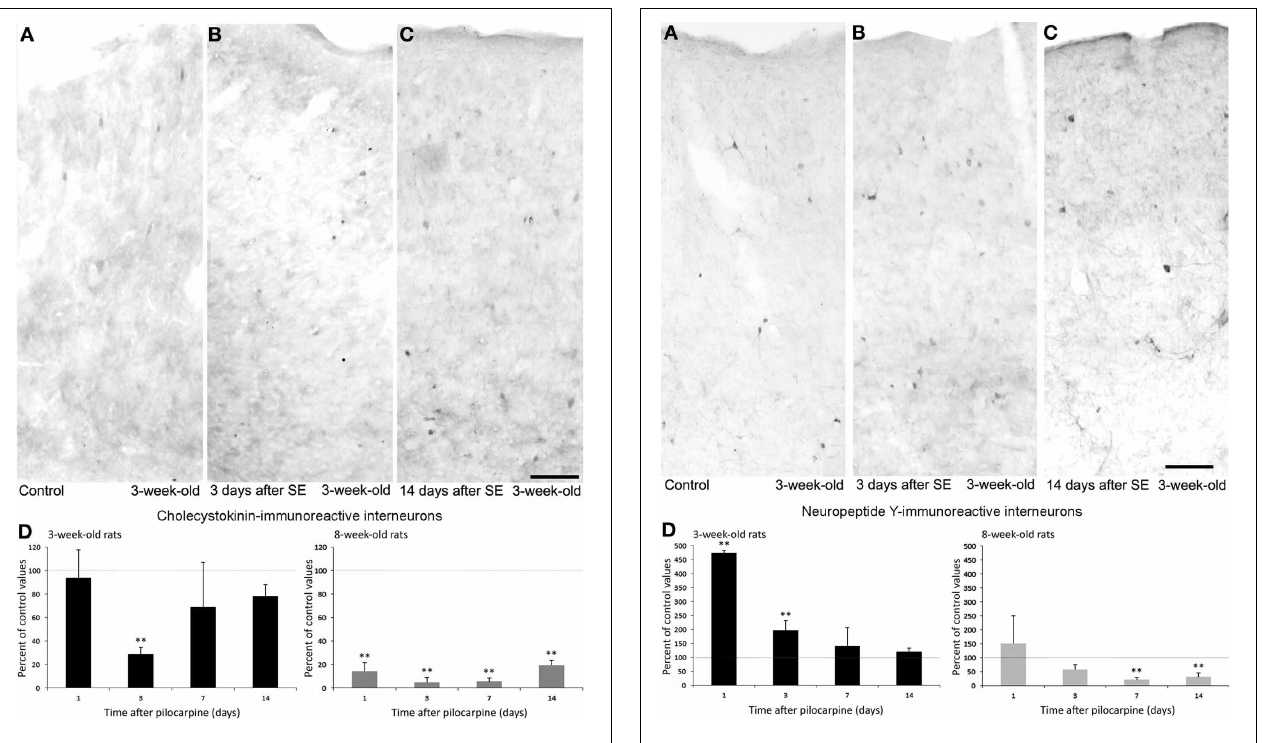
FIGURE 7 | Cholecystokinin (CCK)-immunopositive interneurons in the rat perirhinal cortex. Photomicrographs showing interneurons stained with an antibody against CCK in the perirhinal cortex of 3-week-old rats (A–C) . Specifically, CCK immunostaining in a control, non-epileptic rat, (A) and in pilocarpine-treated rats 3 (B) and 14 days (C) after pilocarpine treatment are respectively shown. (D) Normalized (respect to control) quantification of CCK immunostained neurons in 3 and 8-week-old rats following pilocarpine treatment. Note in the 3-week-old animals ( n = 3–6 for each time interval) that CCK immunostained neurons decrease significantly 3 days after pilocarpine but recovered 7 and 14 days later. Note also that a consistent decrease in CCK-positive neurons was observed in 8-week-old rats ( n = 4–5 for each time interval). ∗∗ p < 0 . 01, analysis of variance followed by Tukey’s test for multiple comparisons. Scale bar: 100 μ m. Animal treatment is described in Biagini et al. (2008). Details of the